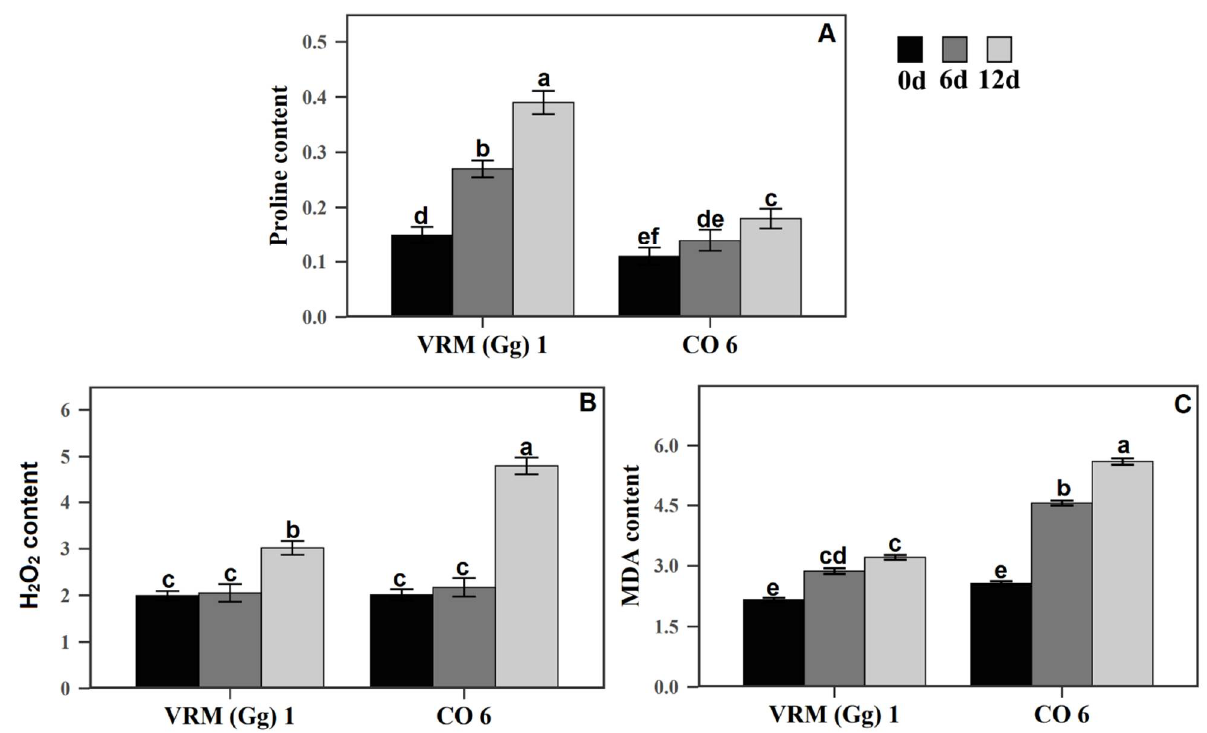
Figure 2. ( A ) Effect of drought stress on proline (µg g −1 FW), ( B ) H 2 O 2 (µmol g −1 FW) , and ( C ) MDA